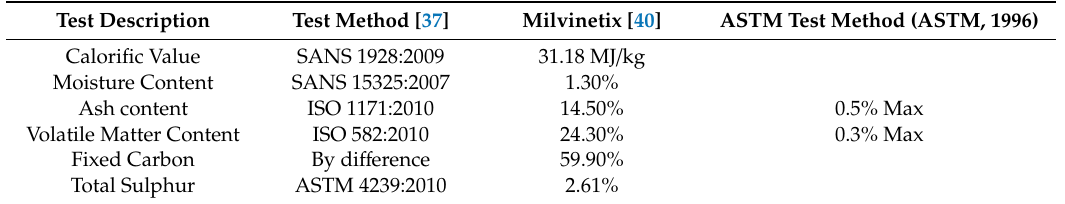
Table 2. Pyrolysis carbon black